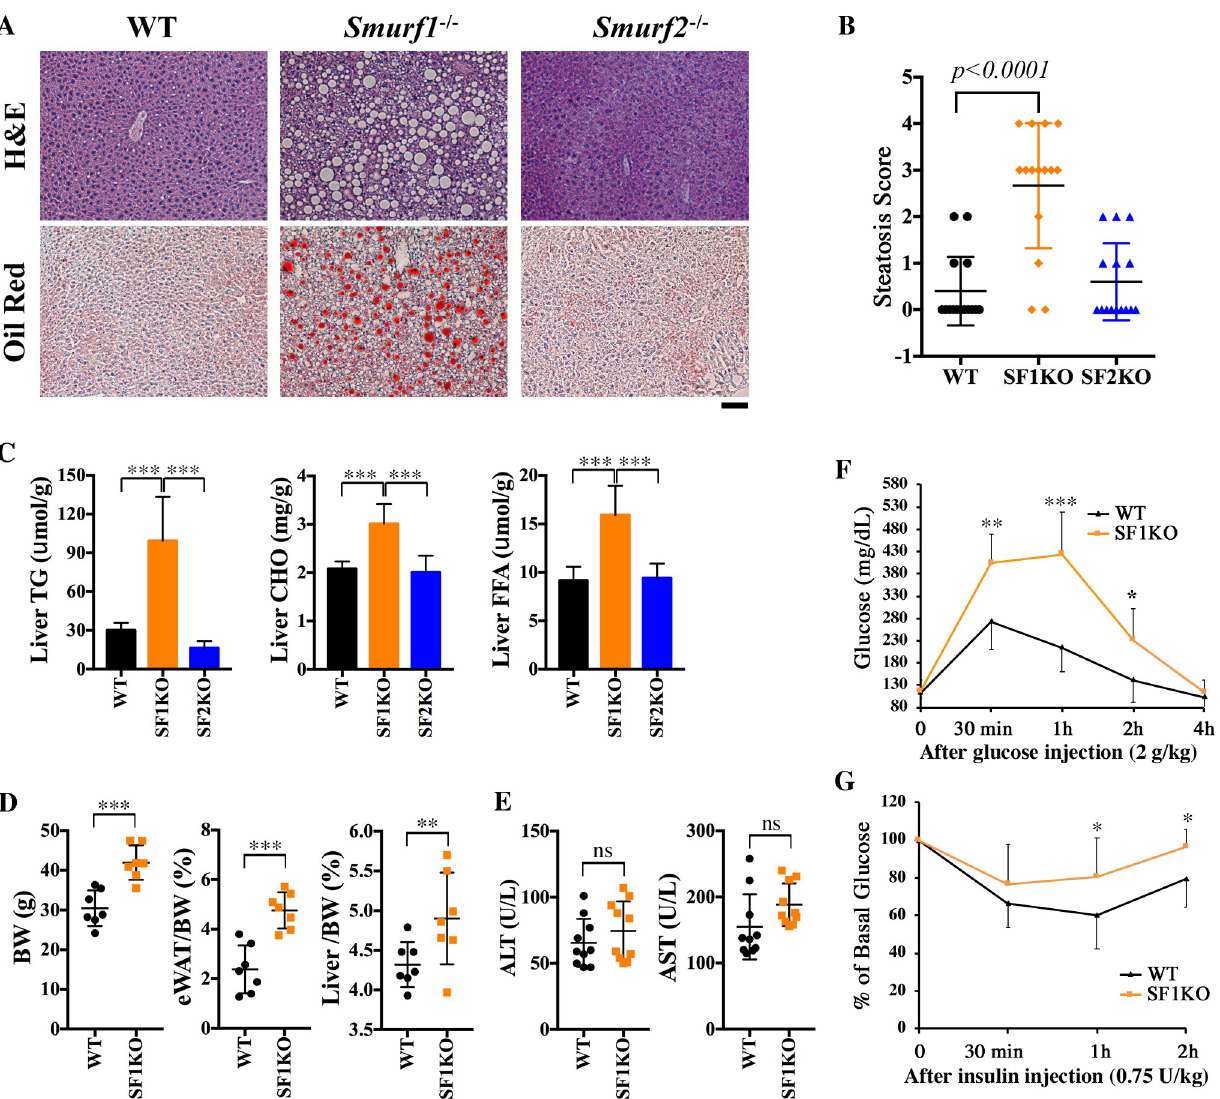
Fig 1. Smurf1KO mice in the mixed BL background developed hepatic steatosis. (A) HE and Oil Red-O staining of liver sections of WT, SF1KO, and SF2KO mice from the BL background at the age of 9–12 months. Bar = 40 μ m. (B) Histological scores of steatosis of mice in (A). For each group, n = 15 (7 males and 8 females). Scores: 0, no steatosis; 1, minimal; 2, mild; 3, moderate; 4, severe. (C) Liver TG, CHO, and FFA content of the above male mice ( n = 7 per group). (D) BW, eWAT/BW ratio, and Liver/BW ratio of the above male mice ( n = 7 per group). (E) Liver ALT and AST activities of the above mice ( n = 10; 5 males, 5 females per group). (F) Glucose and (G) insulin tolerance tests in male mice at the age of 9–12 months ( n = 8 per group). All data are presented as mean ± SD; statistical significance of difference is indicated as � p < 0.05, �� p < 0.01, ��� p < 0.001. Original raw data can be found in S1 Data. ALT, alanine transaminase; AST, aspartate transaminase; BL, mixed black Swiss × 129/SvEv background; BW, body weight; CHO, total cholesterol; eWAT/BW, epididymal WAT weight to body weight; FFA, free fatty acid; HE, hematoxylin–eosin; KO, knockout; Liver/BW, liver weight to body weight; ns, not significant; Smurf, Smad ubiquitin regulatory factor; SF1KO, Smurf1 KO; SF2KO, Smurf2 KO; TG, triglyceride; WAT, white adipose tissue; WT, wild-type.